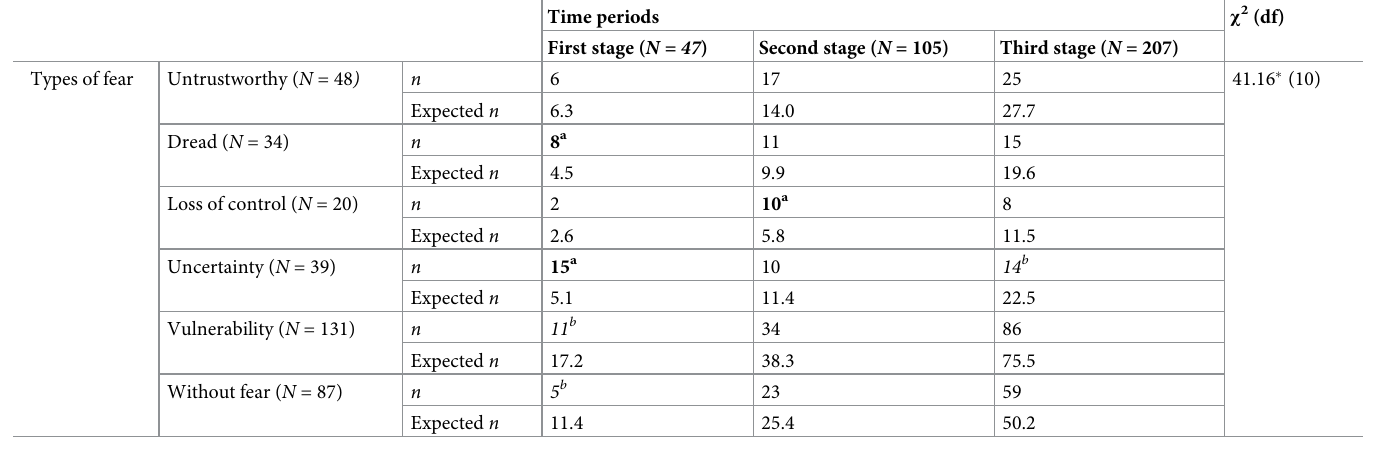
Table 4. A cross-table for sample characteristics with Chi-square analysis.